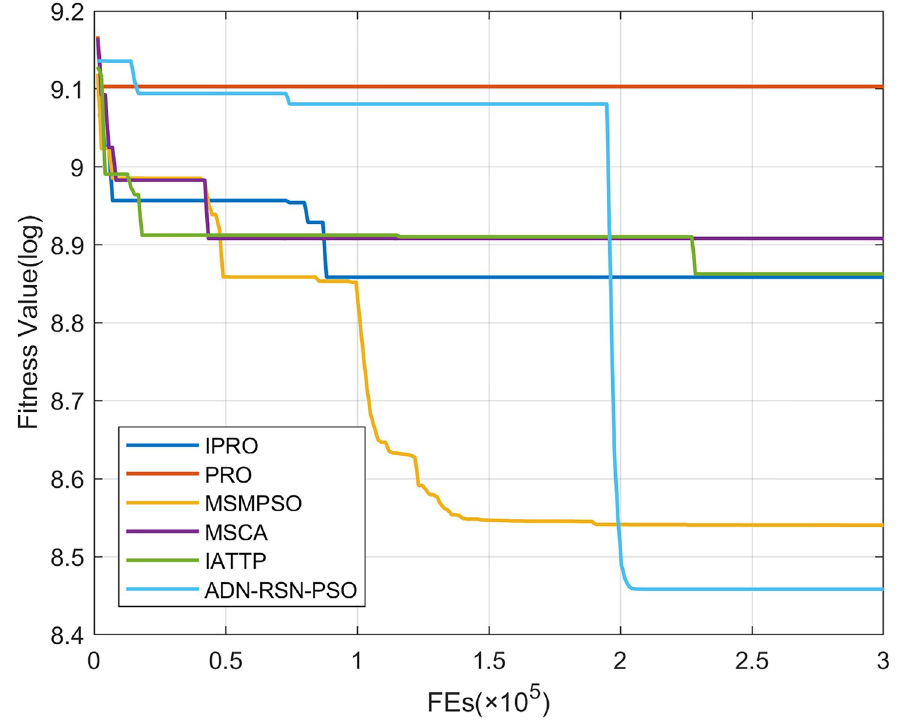
Fig 15. Convergence curves on F15.